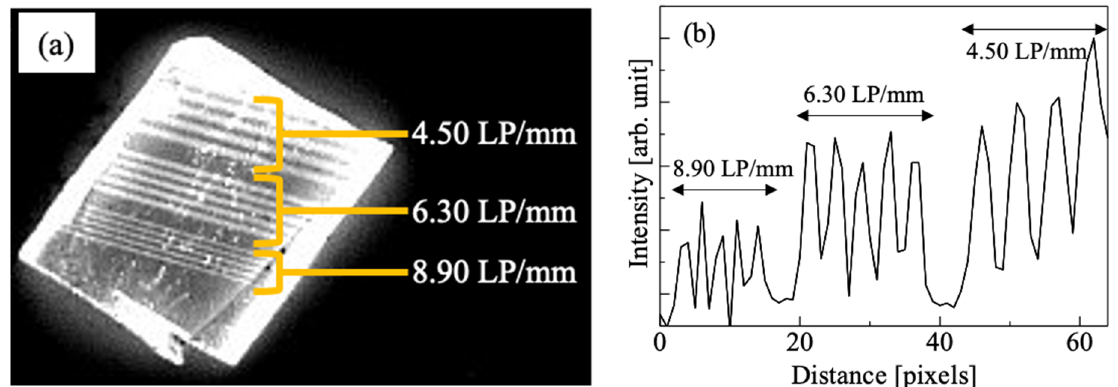
Figure 9. Results of X-ray imaging test of 1% Tb-doped MgGa 2 O 4 taken by TSL: ( a ) obtained image; ( b ) intensity profiles of each line pattern.